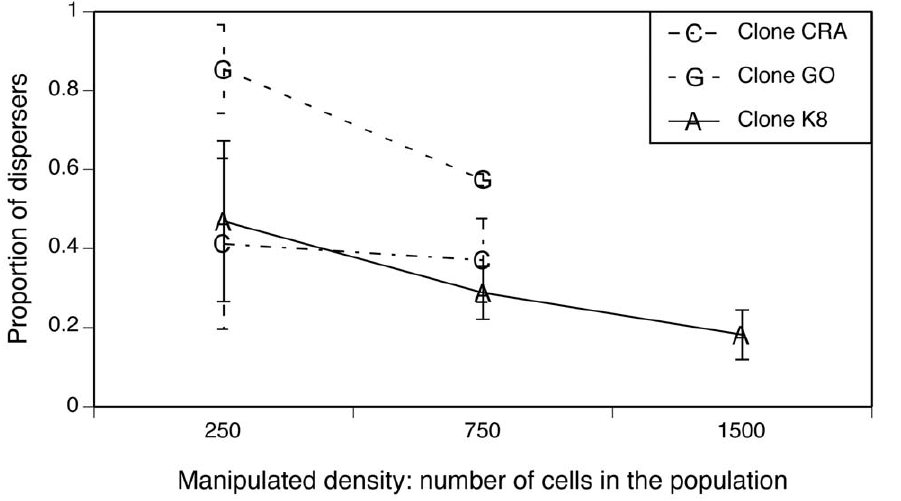
Figure 3. Relationship between experimental population density and the proportion of dispersing cells (experiment 2). We manipulated paramecium cell density, but not their medium. The significant relationship between cell density and dispersal supports the hypothesis that paramecium use physical interactions as cues regarding population density. Symbols indicate means and error bars represent standard errors.